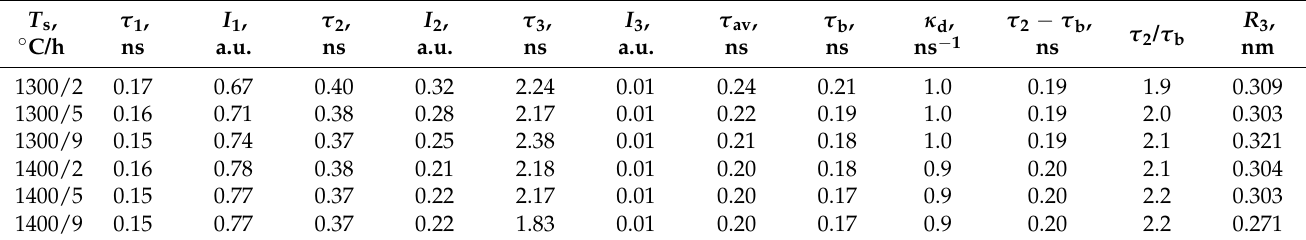
Table 2. PALS characteristics for MgAl 2 O 4 ceramics obtained at T s = 1300–1400 ◦ C during 2, 5, and 9 h. T s , τ 1 ◦ C/h